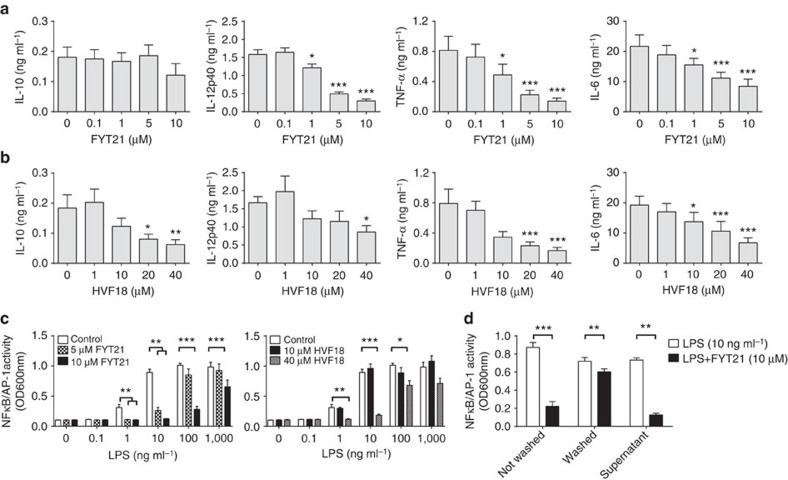
FYT21 reduces pro-inflammatory cytokine release by inhibiting NFκB/AP-1 activation.Whole blood (25%) was incubated overnight at 37 °C with FYT21 (a) or HVF18 (b) and 100 ng ml−1 of LPS, and supernatants were analysed by ELISA. (c) NFκB/AP-1 activity of THP1 reporter cells incubated overnight with a range of LPS with or without FYT21 or HVF18. (d) Cells were incubated with 10 μM FYT21 for 1 h, followed by adding LPS directly to the cells (Not Washed) or washing the cells first to remove unbound peptide. After centrifugation of the latter, the cells were suspended in fresh medium containing LPS (Washed), whereas the supernatants containing unbound peptide were transferred to naive cells followed by stimulation with LPS (Supernatant). Results are means±s.e.m. of 3–9 experiments. Values are significantly (*P<0.05, **P<0.005 and ***P<0.0005) different from the controls as analysed using a one-way ANOVA with a Dunnett's multiple comparisons test (a–c) or a paired t-test (d).